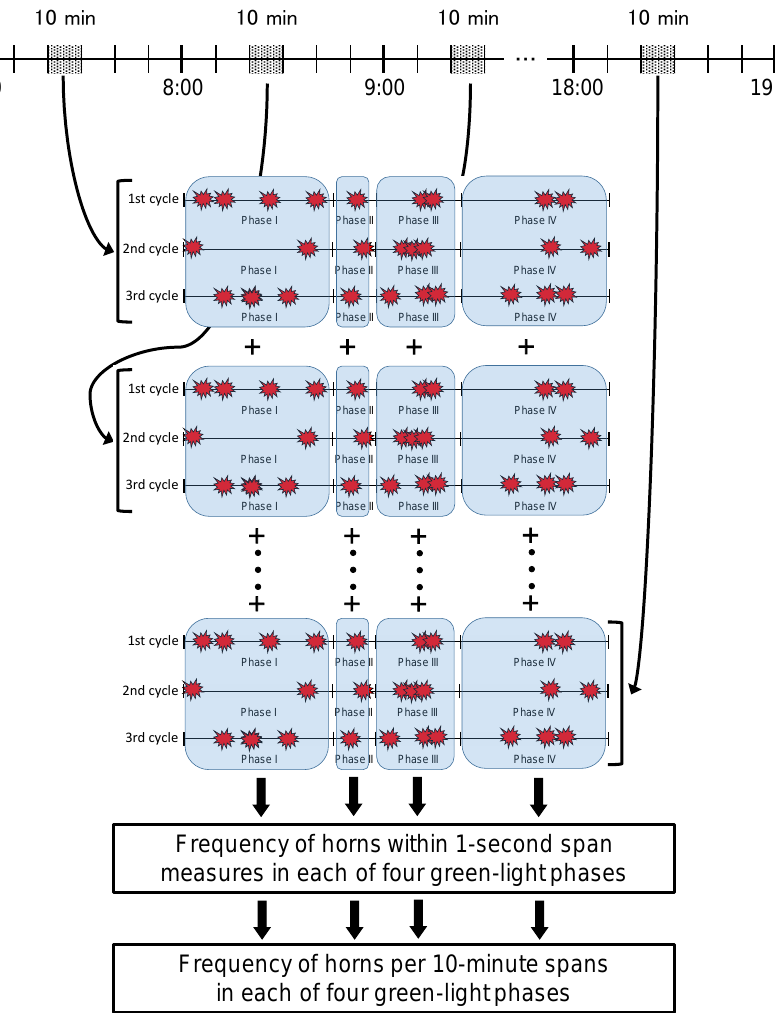
Figure 6. Estimation of the frequency of horn use if the duration of each green light phase is 10 min. The upper part shows 10 min spans in every hour. The middle part shows the counting procedure of the frequency of horn use in each of the four green light phases.